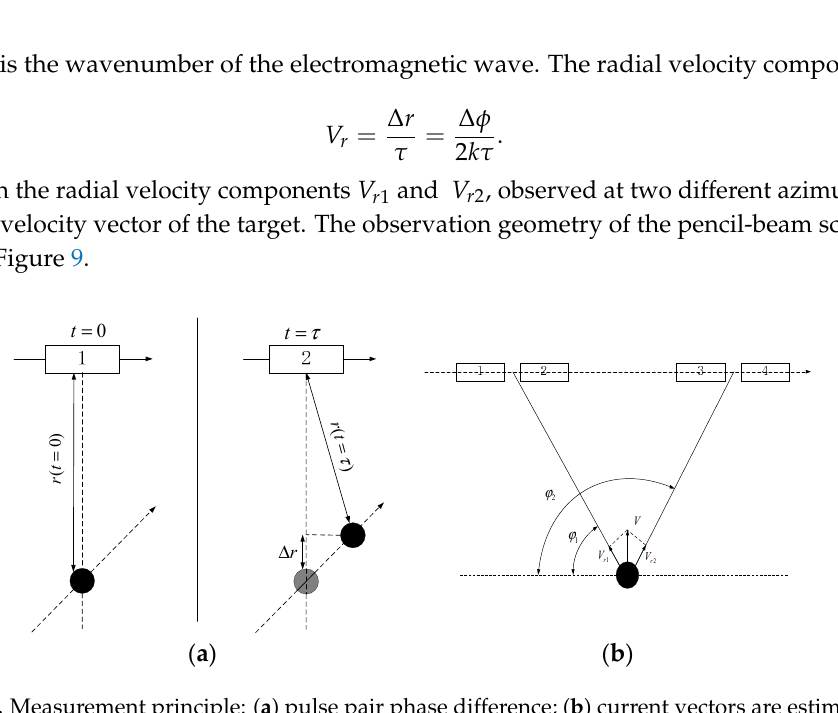
Figure 8. Measurement principle: ( a ) pulse pair phase difference; ( b ) current vectors are estimated by combining multiple (2–4) radial velocity measurements.